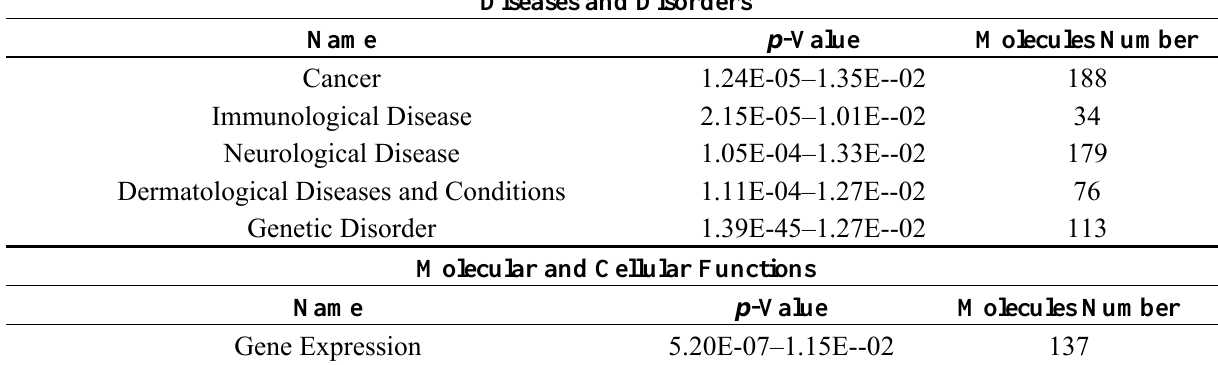
signal pathways. BTG: B-cell translocation gene, VDR: Vitamin D receptor, RXR: Retinoid X receptor, AST: aspartate